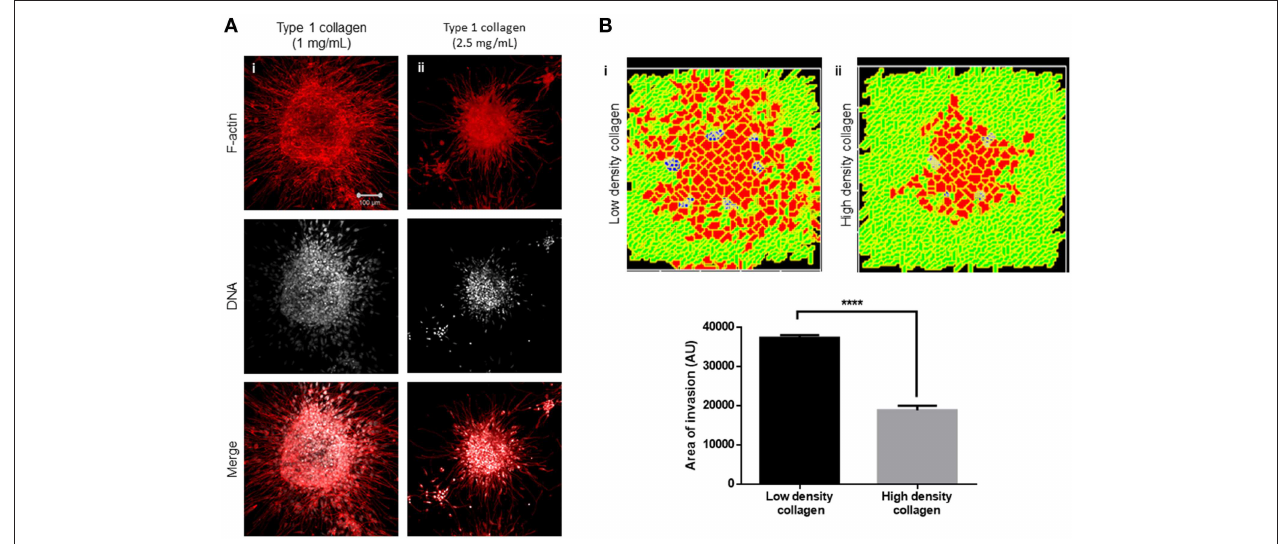
FIGURE 5 | Increased collagen density impairs multiscale invasion. (A) Maximum intensity projections of laser confocal micrographs of MDA-MB-231 cell clusters cultured within specific matrix milieu, fixed and stained for F-actin (using phalloidin; red; top row), DNA (using DAPI; white; middle row), and with both signals merged (bottom row). (i) rBM-coated clusters embedded in 1 mg/ml type 1 collagen show multiscale invasion. (ii) rBM-coated clusters embedded in 2.5 mg/ml type 1 collagen show impaired invasion of cells into surrounding high-density type 1 collagen. (B) Simulations of control conditions (i) and high-density arrangement of fibrillar ECM showing impaired migration of cells at MCS 540. Graph represents invasiveness of cells in simulations associated with (Bi,ii) . Each bar represents mean ± SEM. **** p <